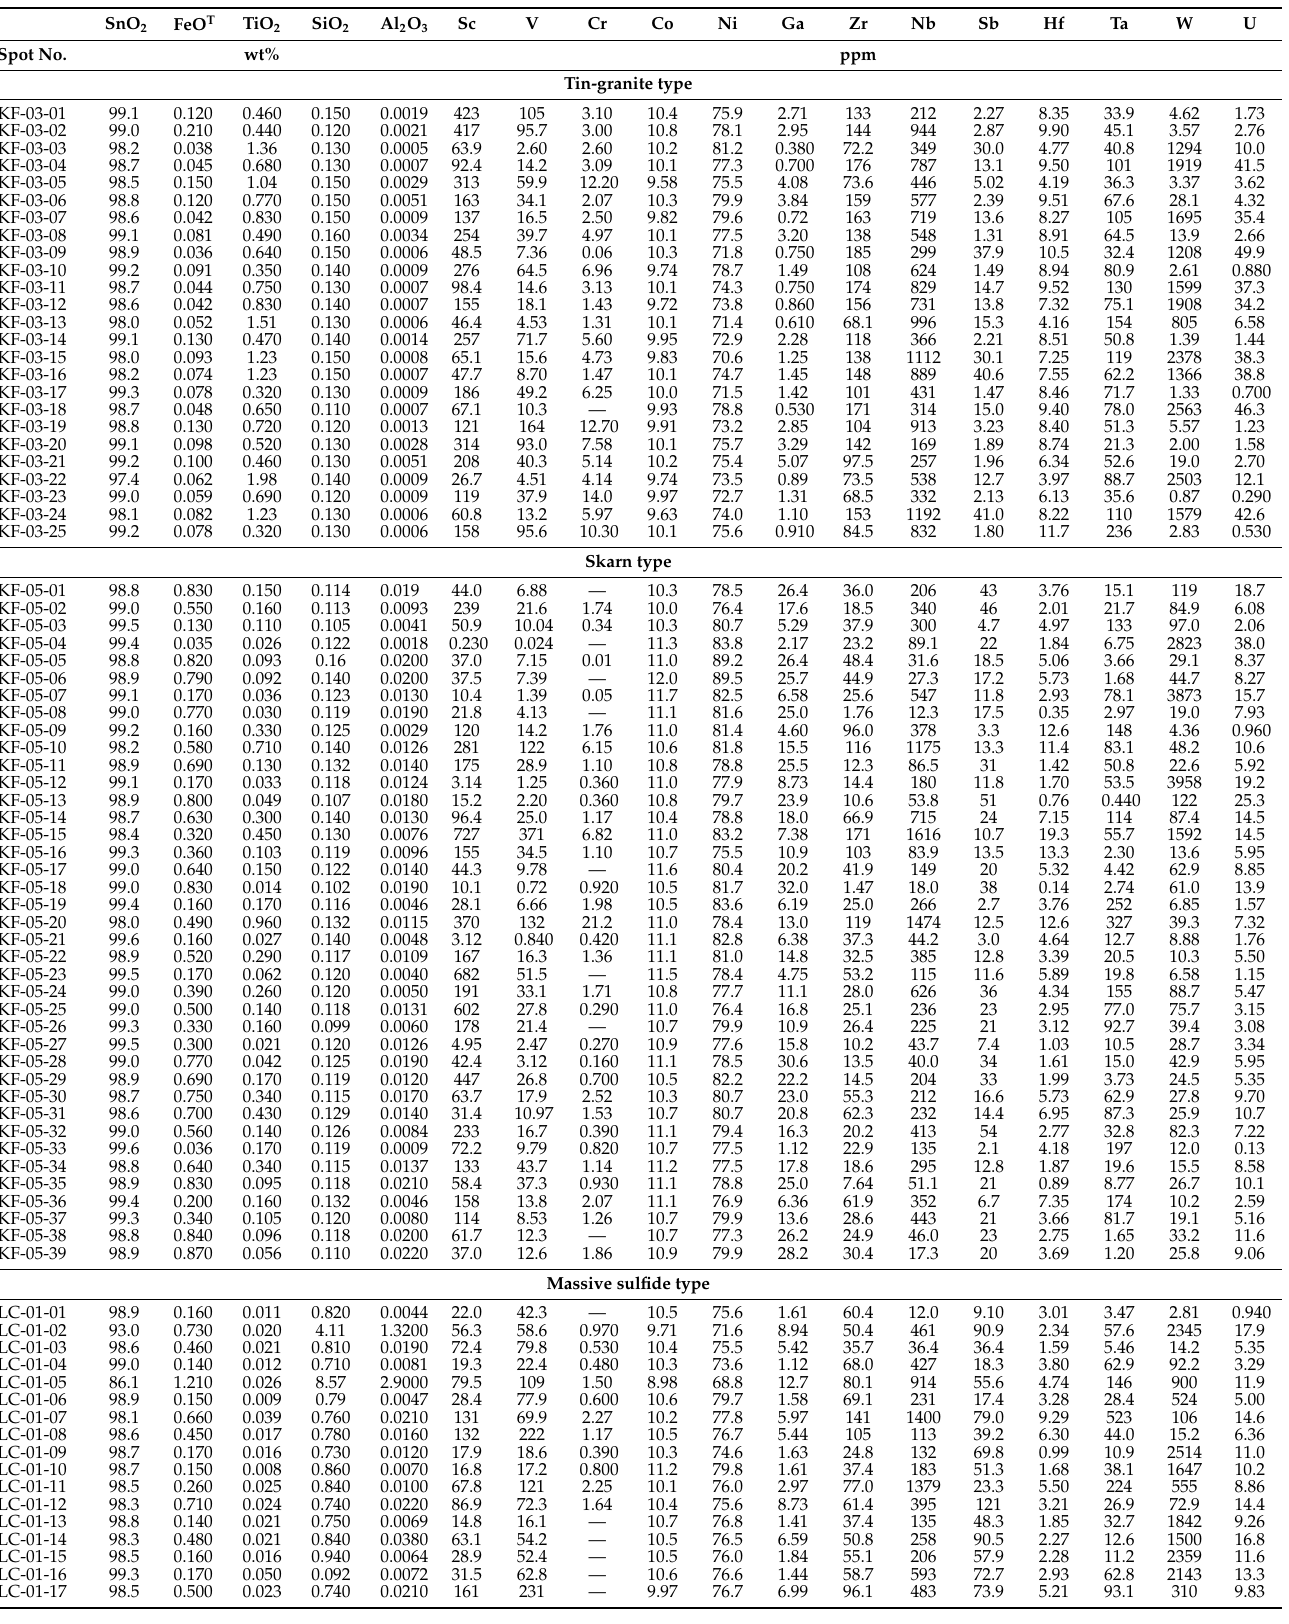
Table 2. Trace element composition of tin-granite, skarn, and massive sulfide types of cassiterite samples analyzed by LA–ICP–MS single spot